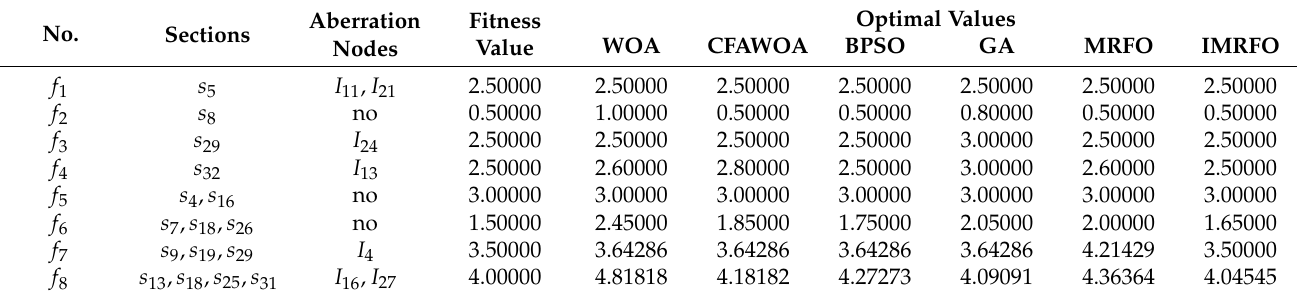
Table 8. Optimal value solving